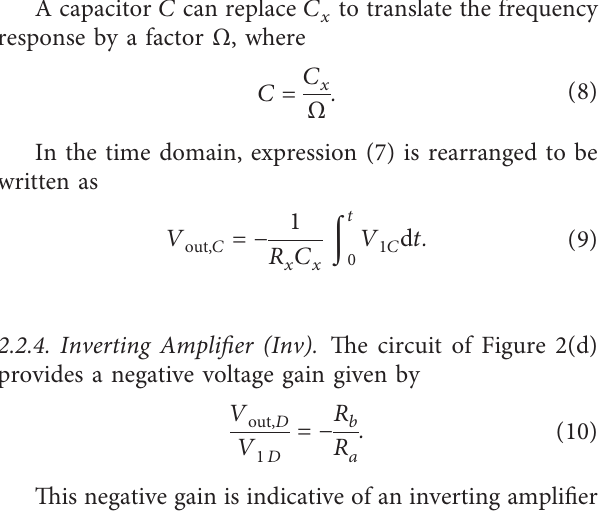
Figure 1: Approximation of a fractional-order passive fractance with α � 0 . 95 and error of